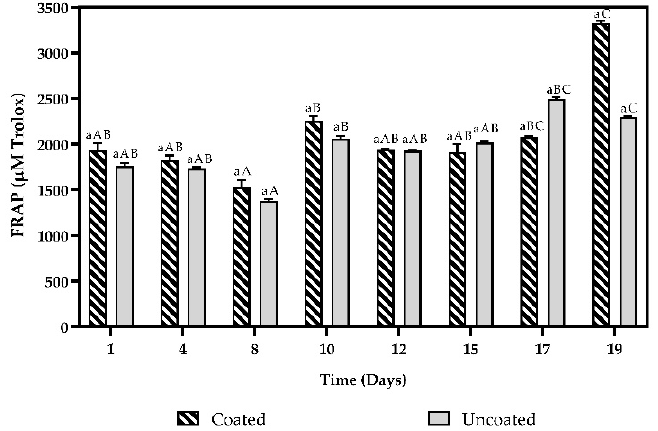
Figure 6. Antioxidant activity by the FRAP method and total phenol content of coated and uncoated fruits. The averages with a common letter are not significantly different according to the Tukey test ( p ≥ 0.05). Uppercase letters differences between days and lowercase letters differences between material coated and uncoated fruits.